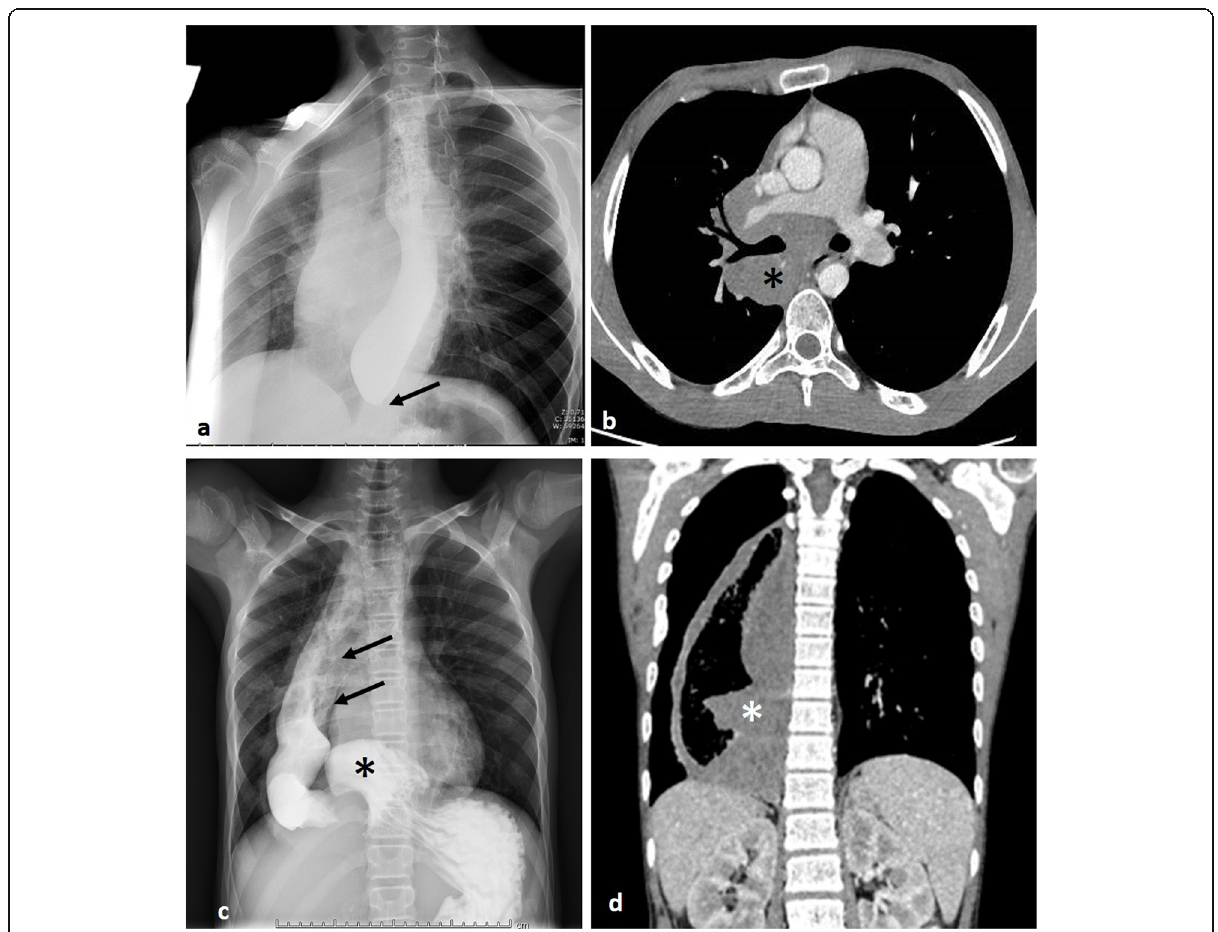
Fig. 7 UGI series of two patients with findings related to the esophagus. a A 15-year-old boy with lymphoma, presented with dysphagia, and significant weight loss, showing esophageal compression by large homogenous opacity and parrot peak appearance of the lower esophagus consistent with achalasia (arrow). b Axial chest CT showing enlarged mediastinal lymph nodes encasing mediastinal structures (asterisk). c A 14-year-old male patient with Alport syndrome presented with vomiting, epigastric pain, and dysphagia; UGI series shows markedly dilated esophagus (arrows) and hiatus hernia (asterisk). d AP shows dilated esophagus with esophageal wall thickening representing leiomyomatosis